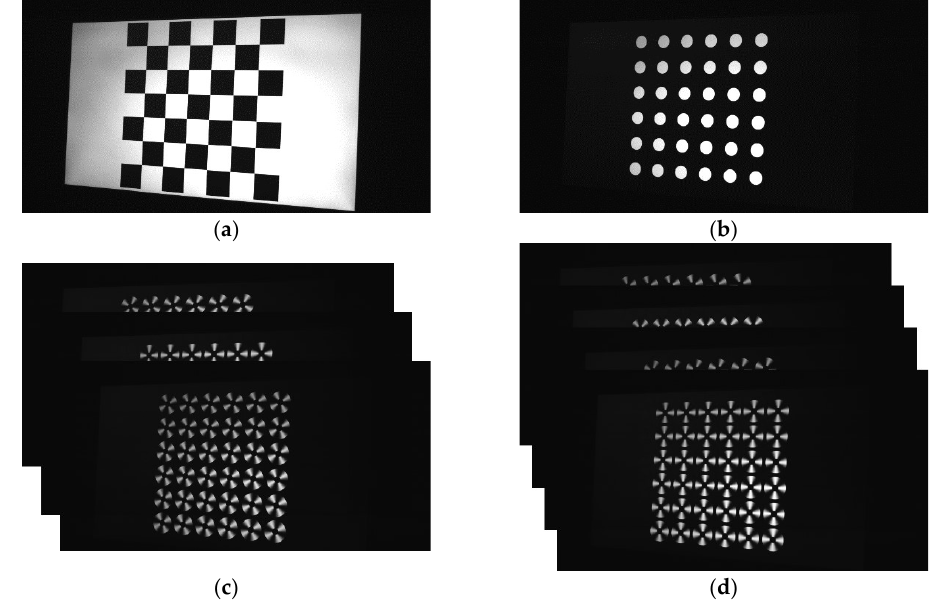
Figure 4. The captured images of different patterns. ( a ) Checkerboard; ( b ) circles; ( c ) three-step PWG arrays; and, ( d ) four-step PWG arrays.